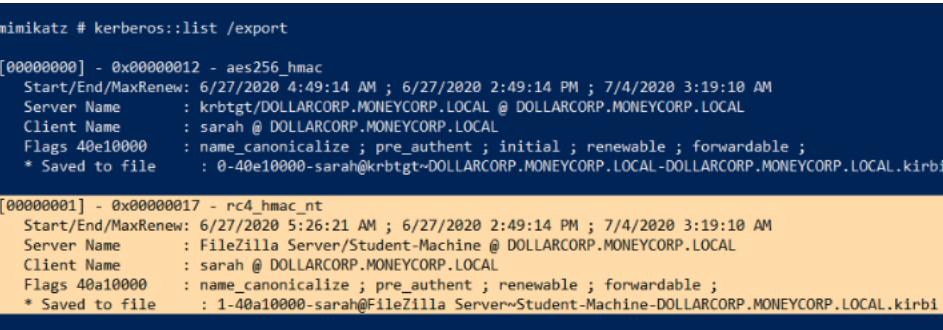
Figure 15. Service Ticket Exported to